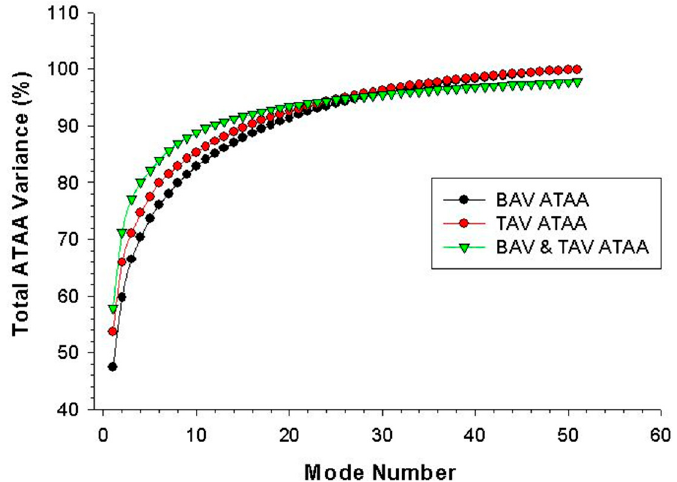
Figure 2. Scree plot of principal component analysis (PCA) analyses done for bicuspid aortic valve (BAV) & tricuspid aortic valve (TAV) ATAA together and for the separated groups of BAV ATAA and TAV ATAA.